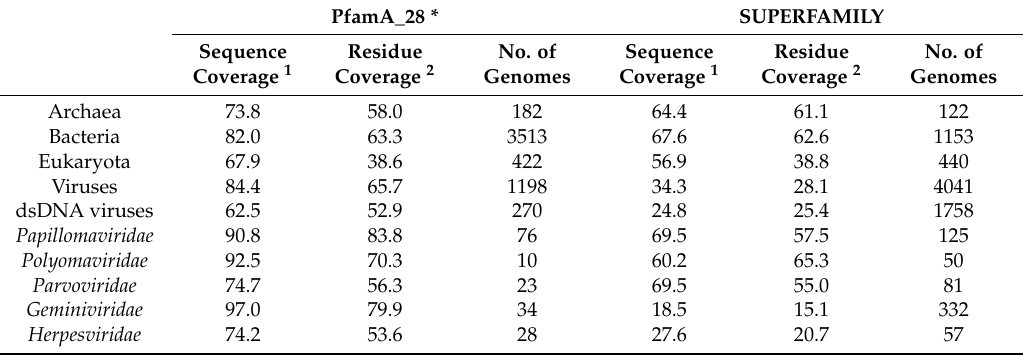
Table 1. Domain coverage comparison in UniProt “complete proteomes” in PfamA and SUPERFAMILY database.